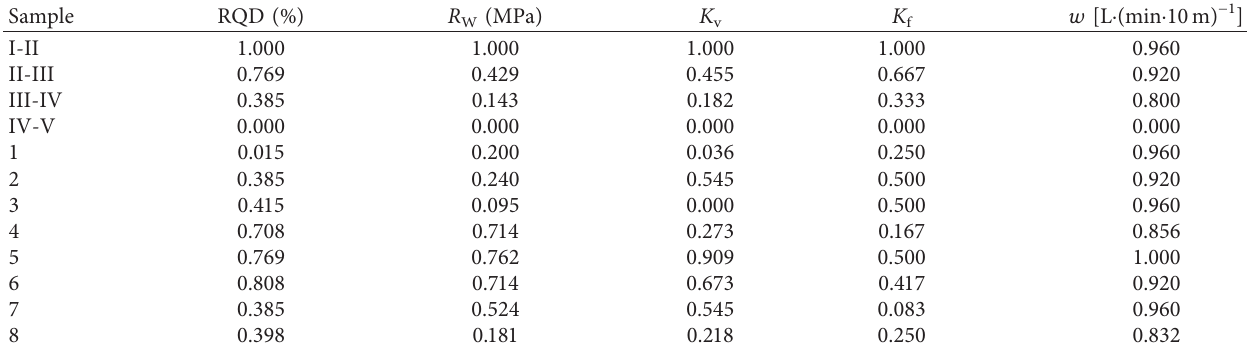
Table 3: Normalized values of rock mass quality indexes.